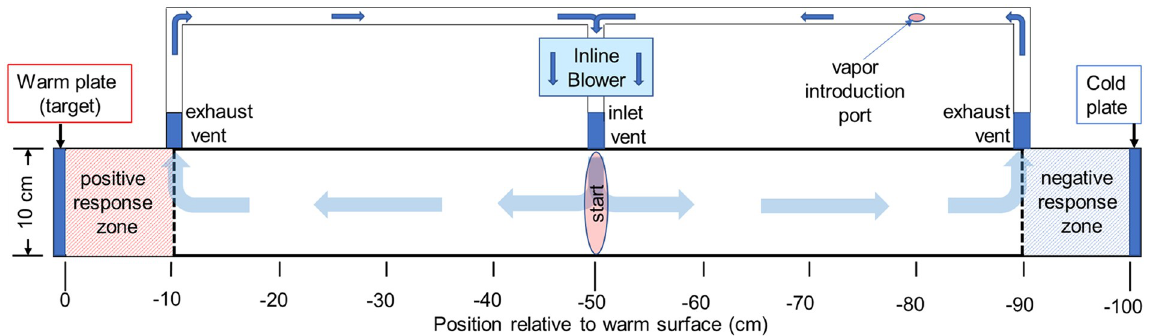
Fig 1. Thermotaxis bioassay arena with closed air circulation